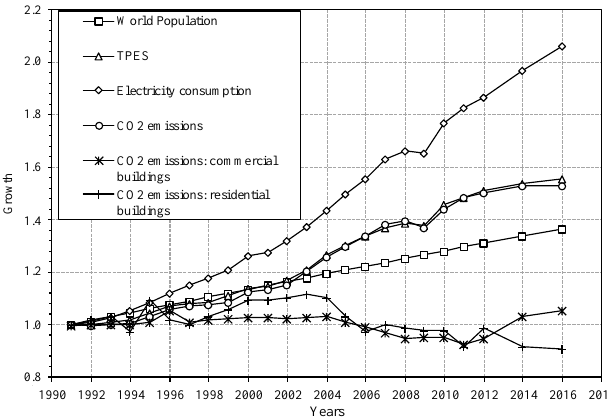
Figure 1. Global indicators evolution [1]. TPES—Total Primary Energy Supply.